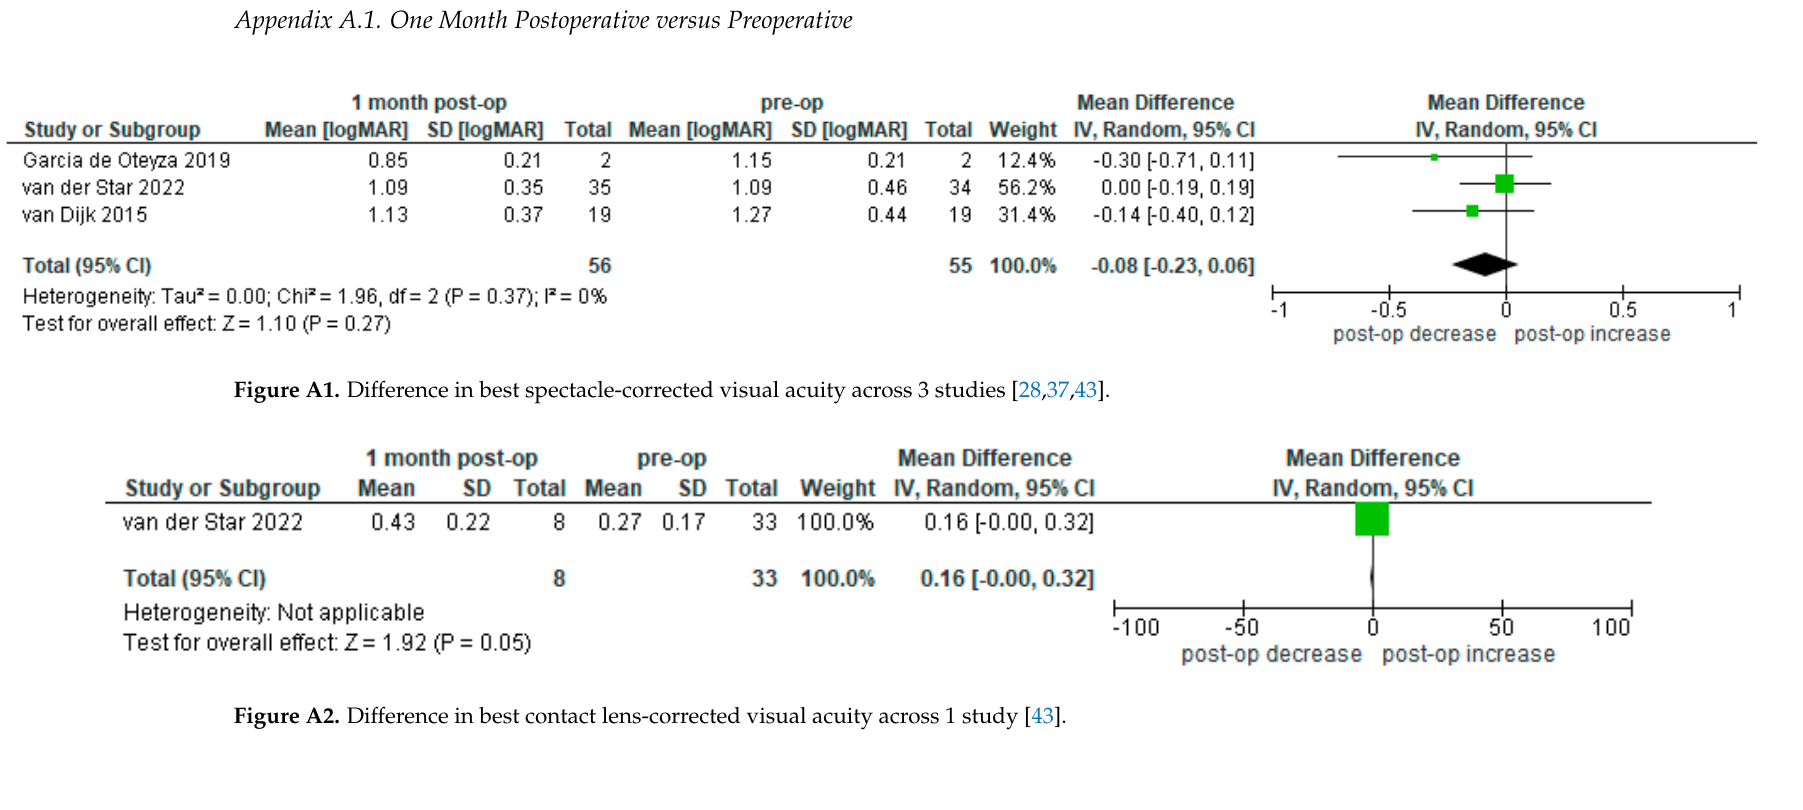
Figure A3. Di ff erence in pachymetry thinnest point across 3 studies [28,31,43].